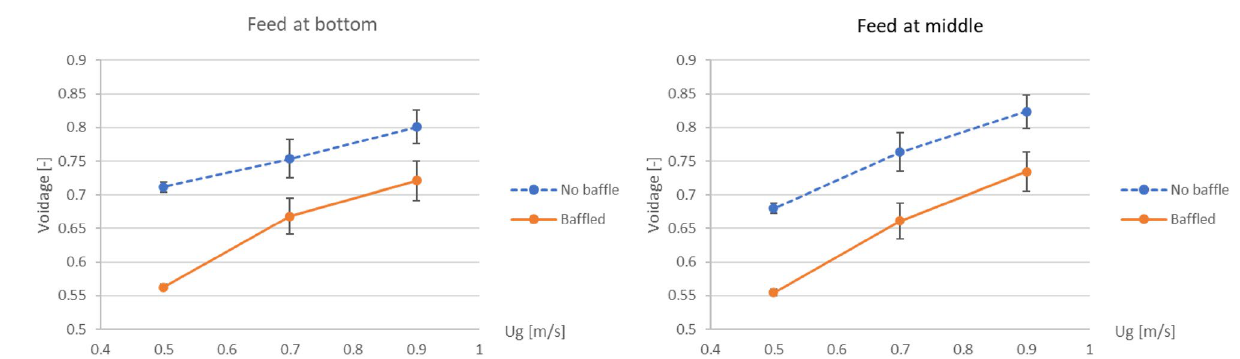
Figure 10. Effect of the baffles installation on maximum of cross-sectional averaged voidage in bed as a function of gas inlet velocity in cases that biomass was fed at bottom (left) and at middle